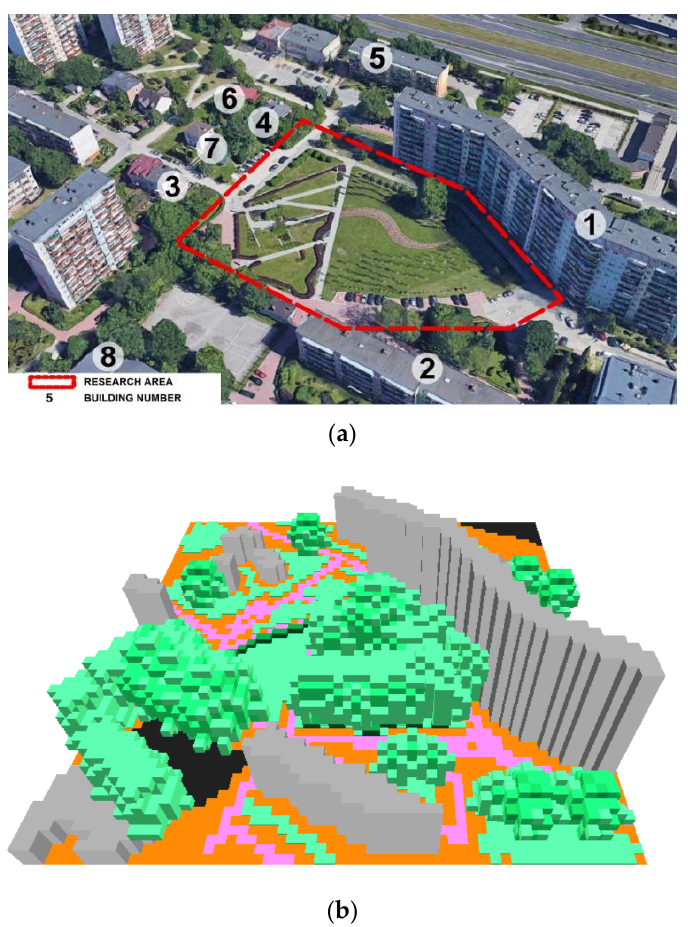
Figure 2. ( a ) Survey area with numbers, ( b ) view of the ENVI-met survey model area. Table 2. Summary of pavements in the study